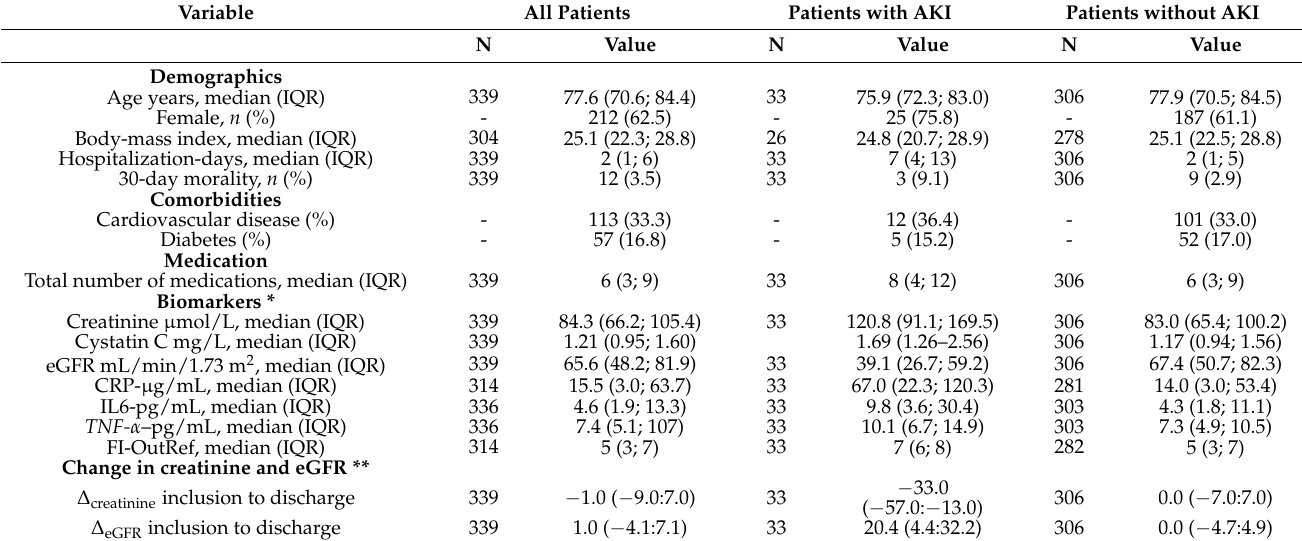
Table 1. Patient characteristics for all included patients, patients with and without